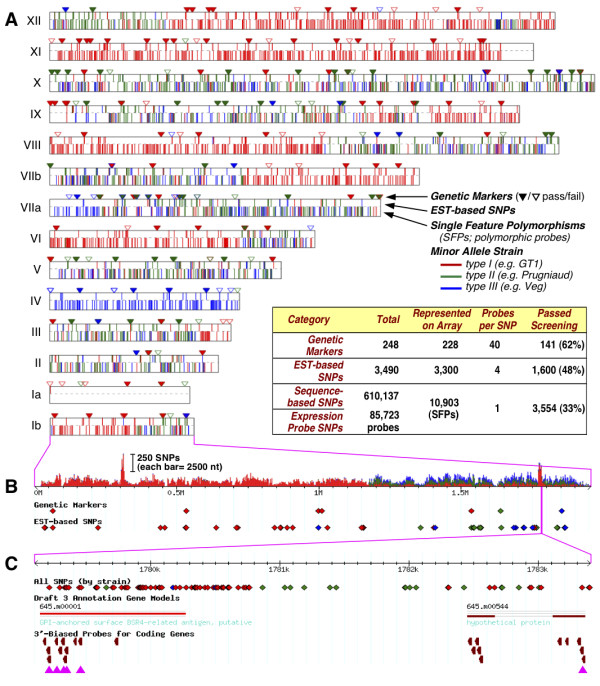
Genotyping design. A, The chromosome map illustrates three tiers of genotyping content present on the Toxoplasma microarray. The triangles represent the published RFLP markers, and represent genotyping capabilities prior to this work. The filled triangles represent those markers for which we have provided probesets that passed a rigorous screening process. The top half of each chromosome bar represents the EST-based SNPs, and the bottom half shows the SFPs that have passed screening. The table lists the exact numbers of SNPs represented on the array, those that passed screening, and the probe content for each. B, An expanded view of chromosome Ib indicates the SNP frequency derived from comparative sequence analysis for the three archetypal strains (see Additional File 3), and indicates the location of probesets designed for SNP detection. C, A magnified view of chromosome Ib demonstrating the overlap of SNPs with probes primarily designed for transcriptional profiling. Pink triangles indicate those probes which overlap SNP locations, and can be used to detect SFPs (see text).